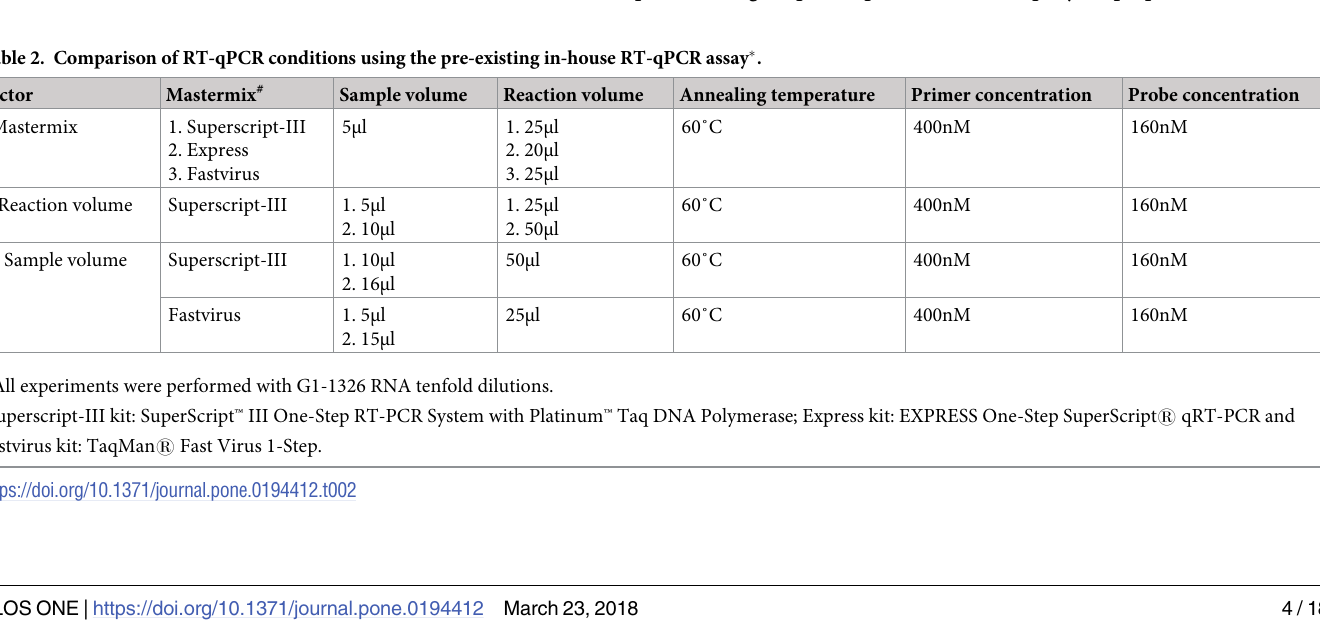
Table 1; 2) Reaction volumes (25 vs 50μL); 3) Sample volumes (5–16μL), see Table 2. All RT- qPCR assays for optimisation and subsequent experiments were run using a CFX96 TM qPCR detection system (Biorad laboratories). Cq > 40 were reported as negative, and (cid:20) 40 as positive. Selection of the best performing RT-qPCR systems. The ten different systems were compared by testing them on 7 tenfold dilutions of JEV G1-1326 RNA in duplicate, and G3 RP9-190 RNA tested once, using ‘Superscript-III kit’ following standard conditions, see Table 1. On the basis of these results, the three RT-qPCR systems with the lowest limit of detection (LOD), i.e. highest dilution found positive for all replicates, were selected for optimisation.